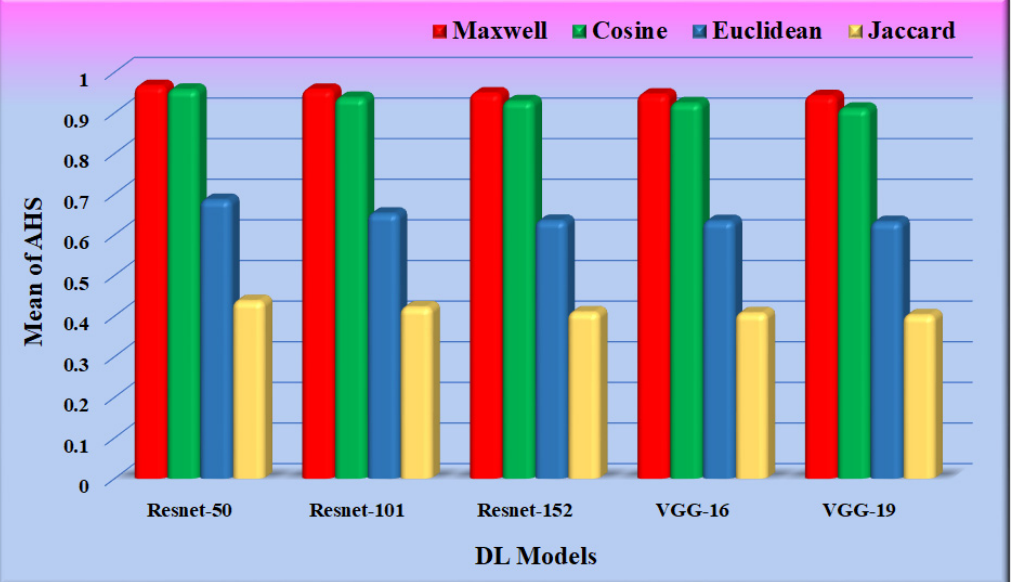
Figure 12. Graph for mean/standard deviation of AHS.